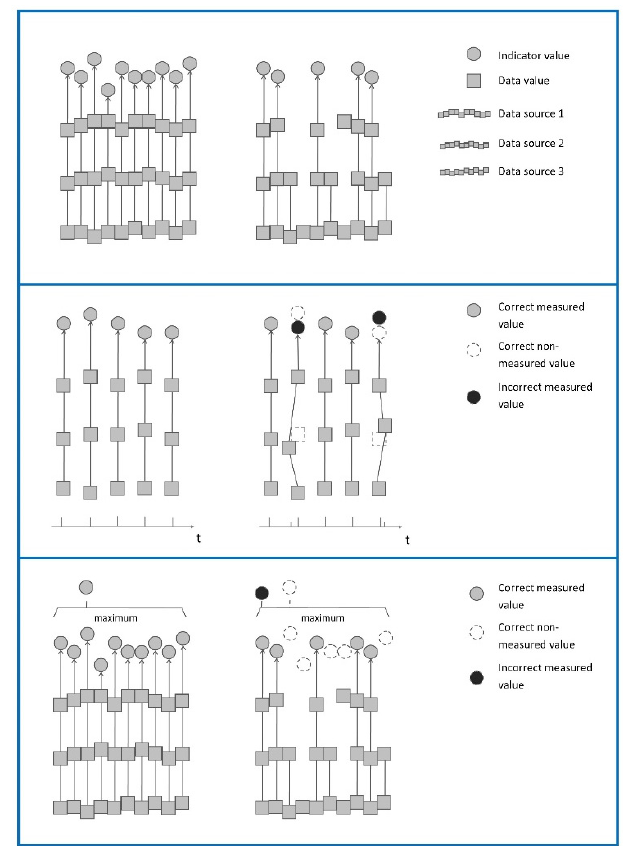
Figure 11. Complex relation between logging frequency and indicator.